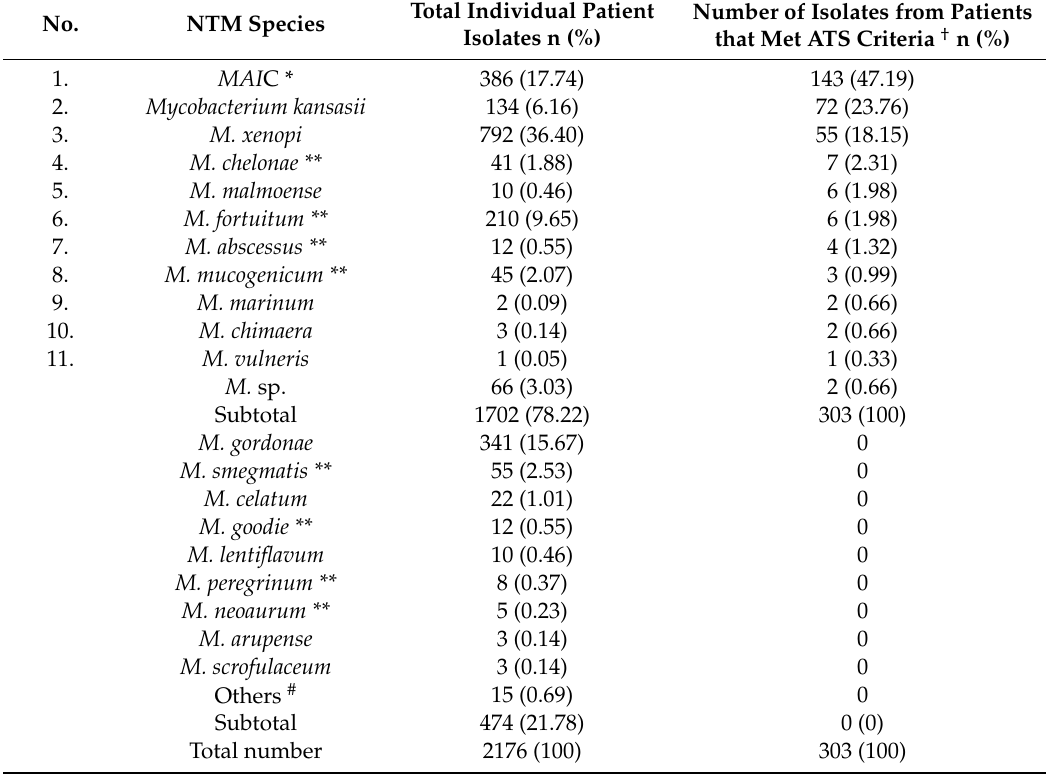
Table 1. Species distribution in human isolates of non-tuberculous mycobacteria (NTM) in Moravian and Silesian territories (Czech Republic) during the years 2012–2018. NTM species in the column are ordered by the highest number of causative agents of the diseases. (Numbered NTM species were clinically